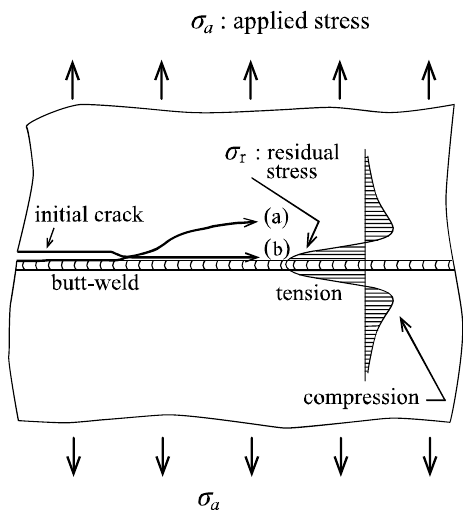
Figure 9: A brittle crack propagating parallel to a welded joint; (a) crack propagation in the base metal; (b) crack propagation along butt-weld